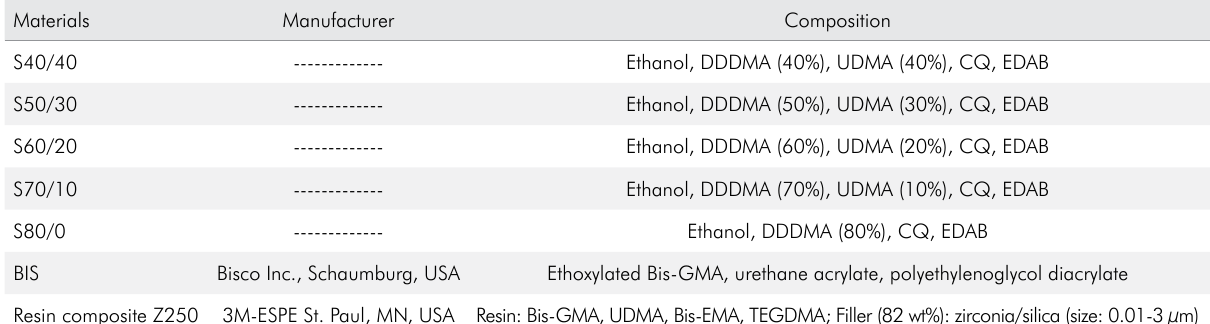
Table 1. Materials used in the study according to the composition. Materials